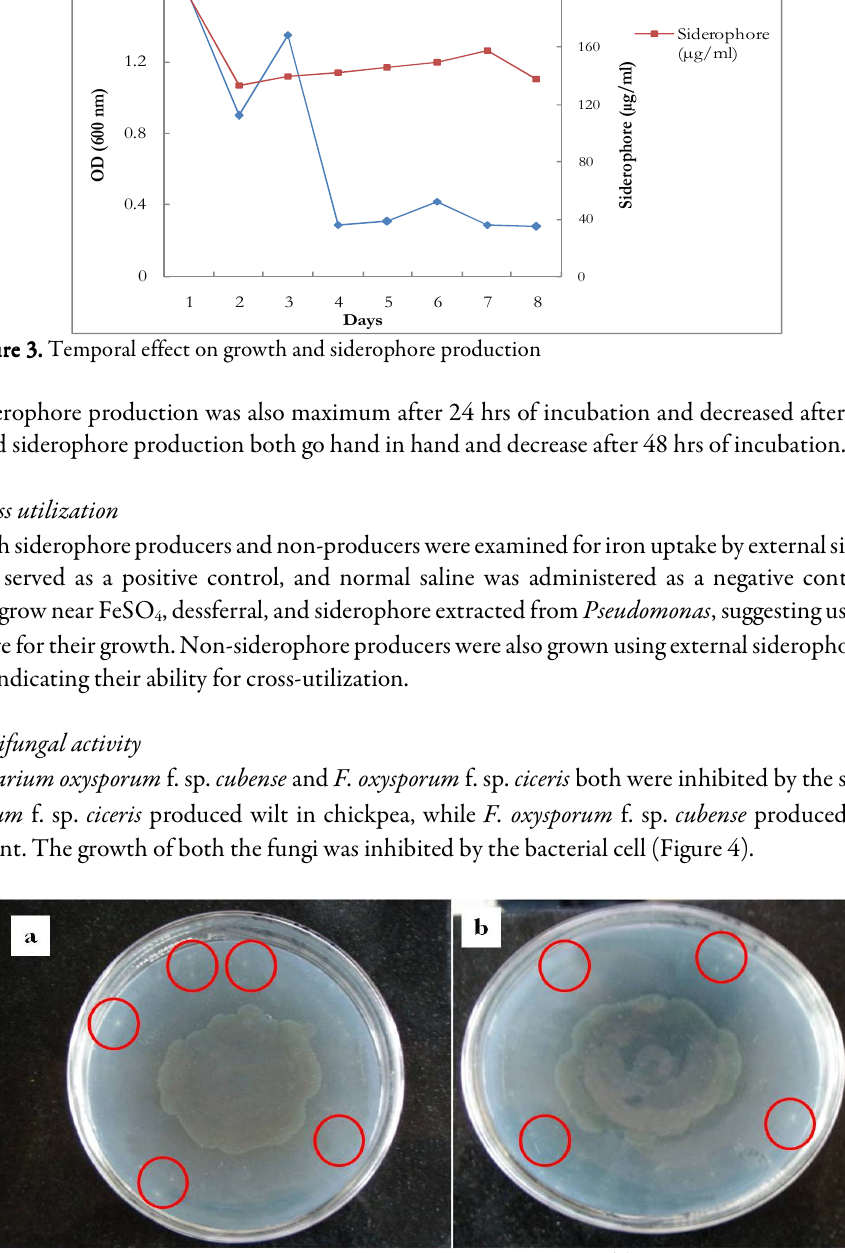
Figure 4. Antagonistic activity against Fusarium oxysporum f. sp. cubense (a) and F. oxysporum f. sp.